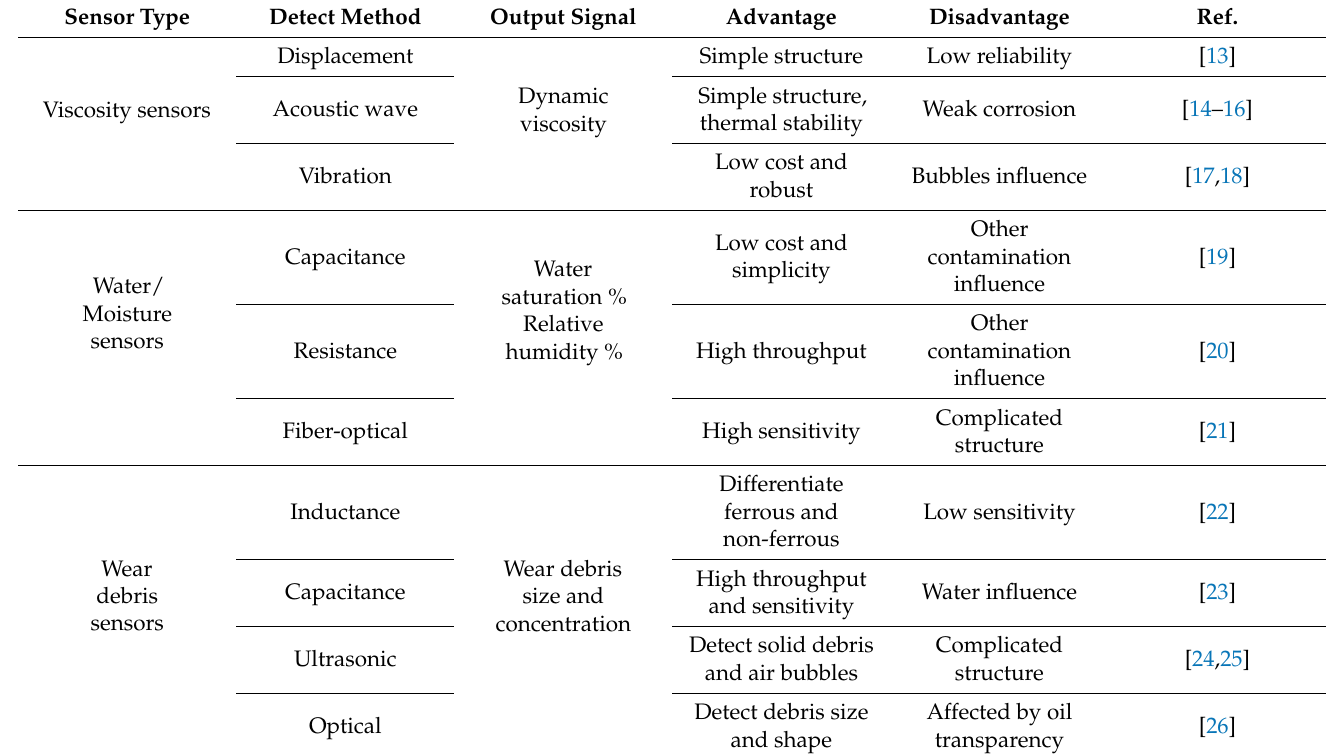
Table 1. Oil sensors for hydraulic